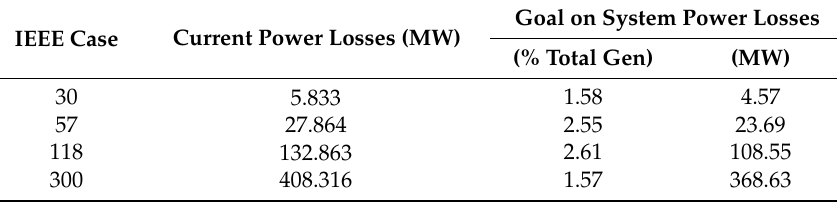
Table 3. Goals on system power losses for fitness function